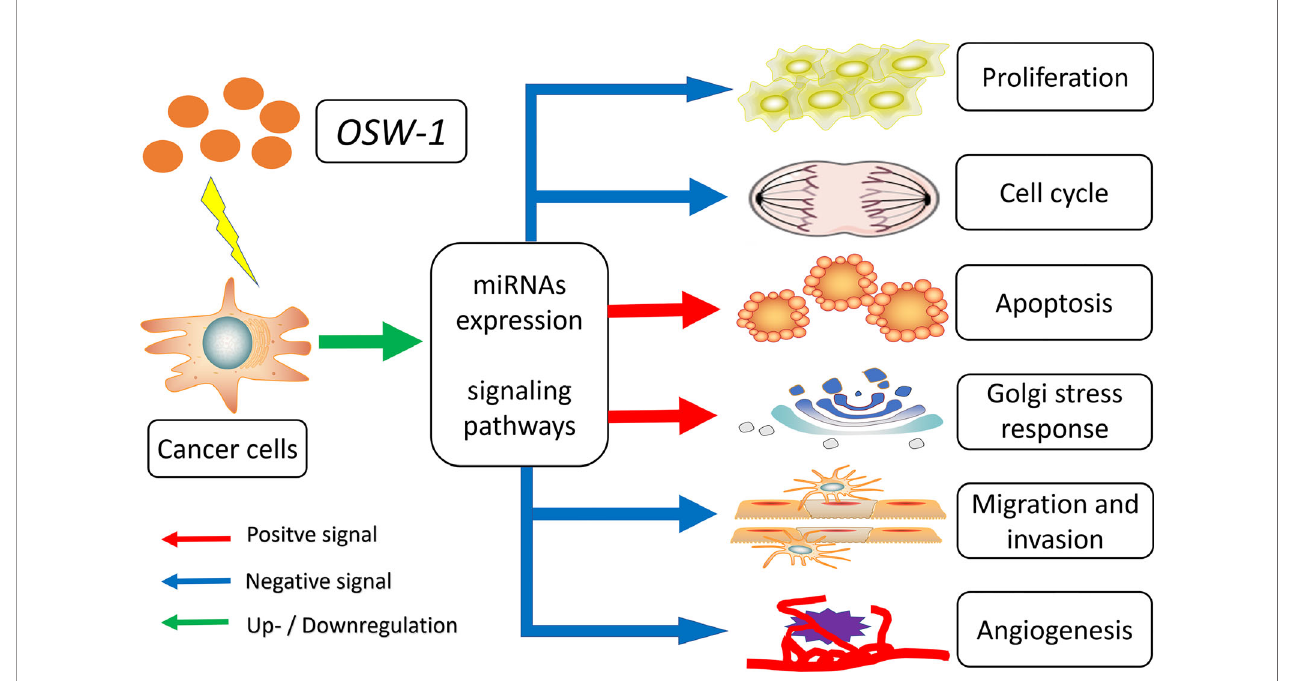
FIGURE 3 | Overview of the anticancer mechanisms of OSW-1 in cancer